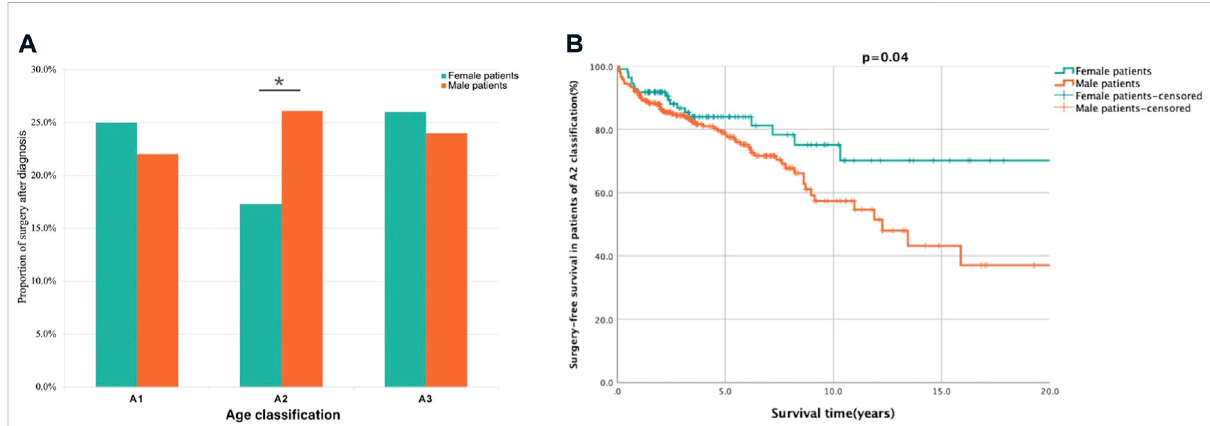
FIGURE 3 AnalysisofsurgeryproportionandsurvivalinfemaleandmalepatientsbasedonAclassi fi cation.Description: (A) Theproportionofsurgeryafter diagnosis in male patients was lower than female patients in A1 and A3 classi fi cation but signi fi cantly higher in A2 classi fi cation. (B) The surgery-free survival was shorted in male patients of A2 classi fi cation. * p < 0.05. Surgery-free after diagnosis survival was de fi ned as the period from diagnosis to CD related